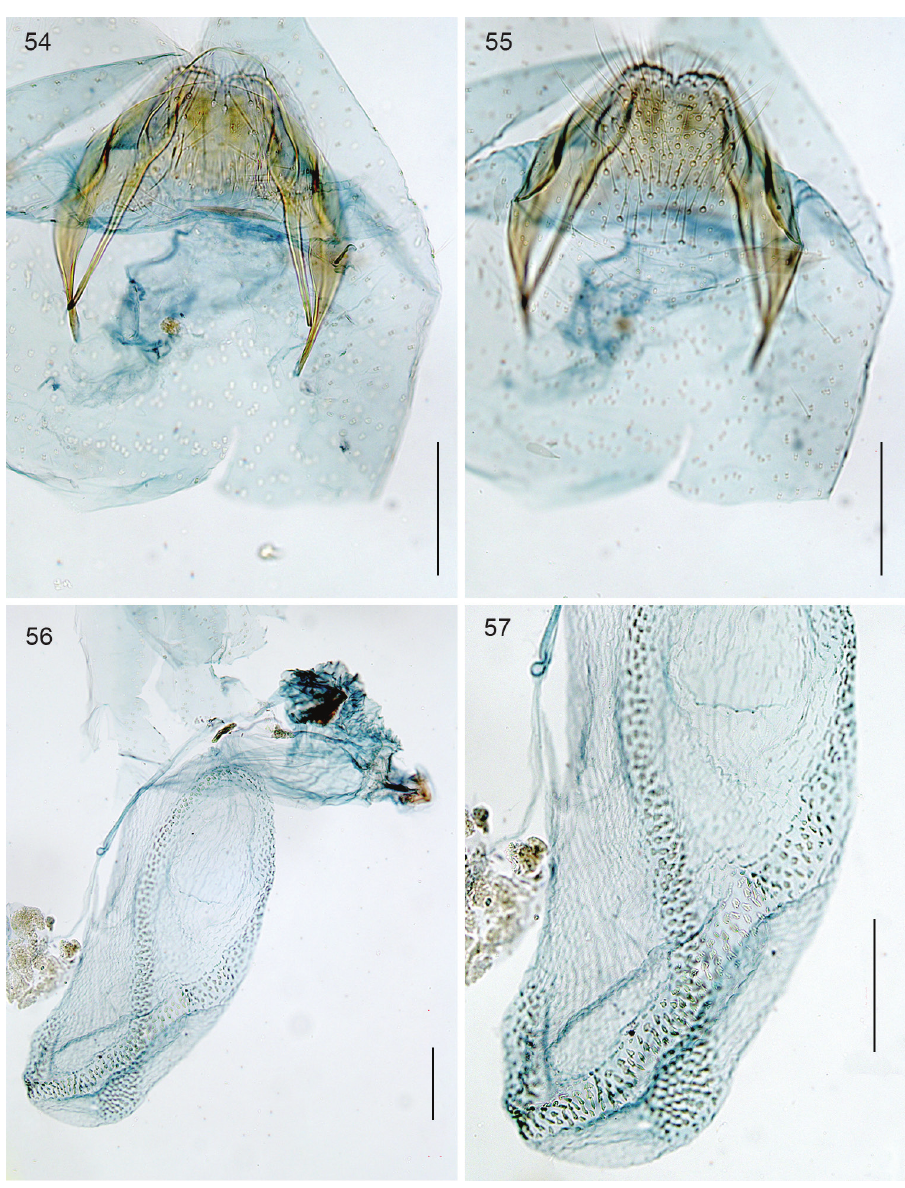
Figures 54–57. Stigmella molinensis , female genitalia, slide EvN4219. 54, 55 Terminal segments, re- spectively focussed dorsally, showing T8 and ventrally, showing setae on S8 56, 57 Bursa and detail. Scale bars:100